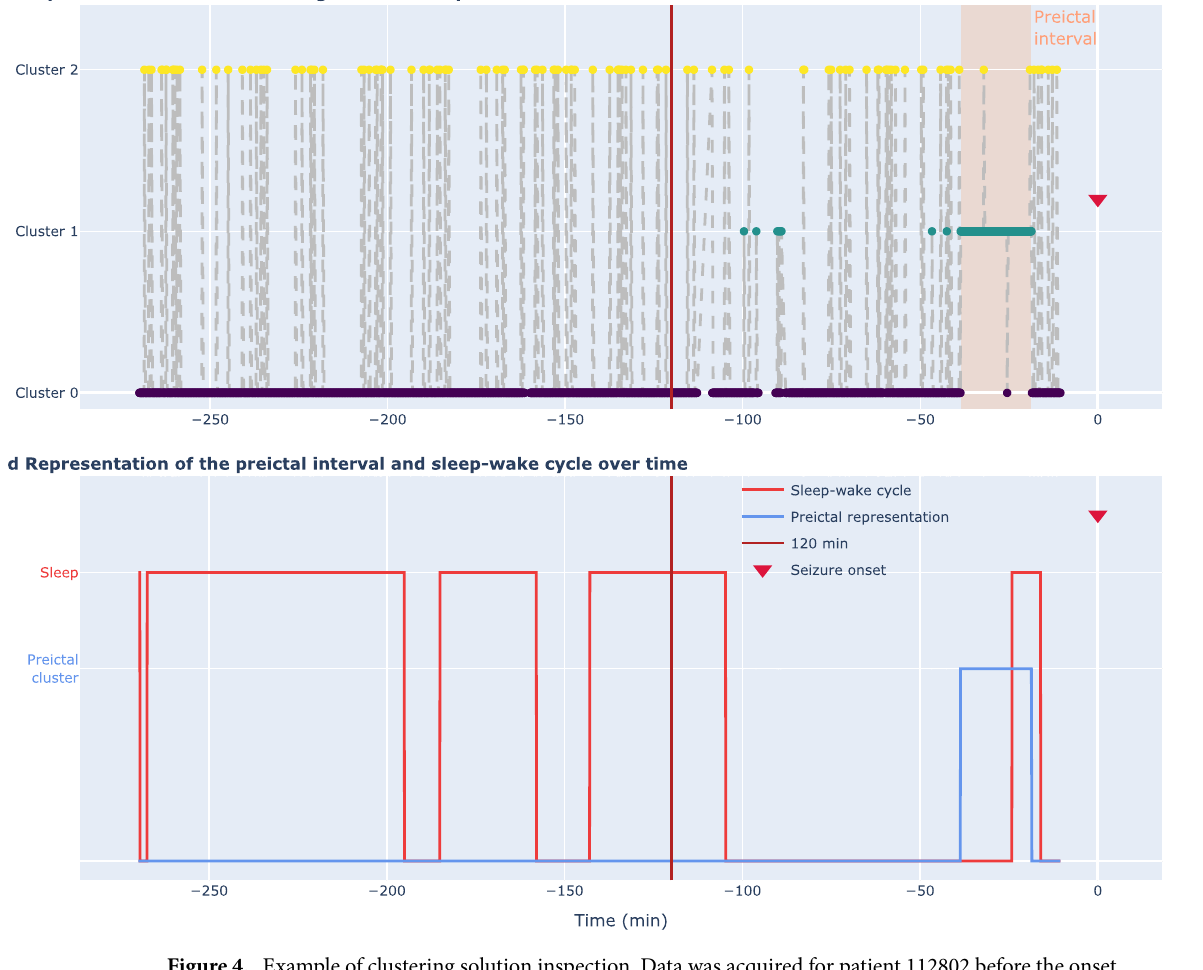
Figure 4. Example of clustering solution inspection. Data was acquired for patient 112802 before the onset of seizure 6. ( a ) UMAP dimensionality reduction was performed on multivariate features. ( b ) The clustering solution was obtained using HDBSCAN. ( c ) Representation of the clustering solution and the preictal interval categorised as category 3. The preictal interval started 38.6 min before seizure onset, lasted for 19.9 min and verified 98.7% density. ( d ) Representation of the preictal interval and sleep-wake cycle, with a phi coefficient of